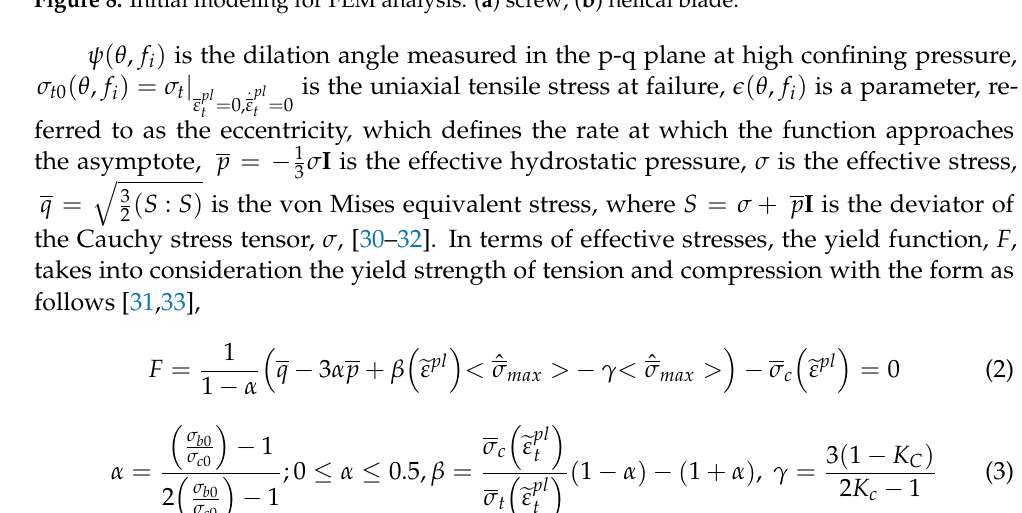
Figure 8. Initial modeling for FEM analysis: ( a ) screw; ( b ) helical blade.